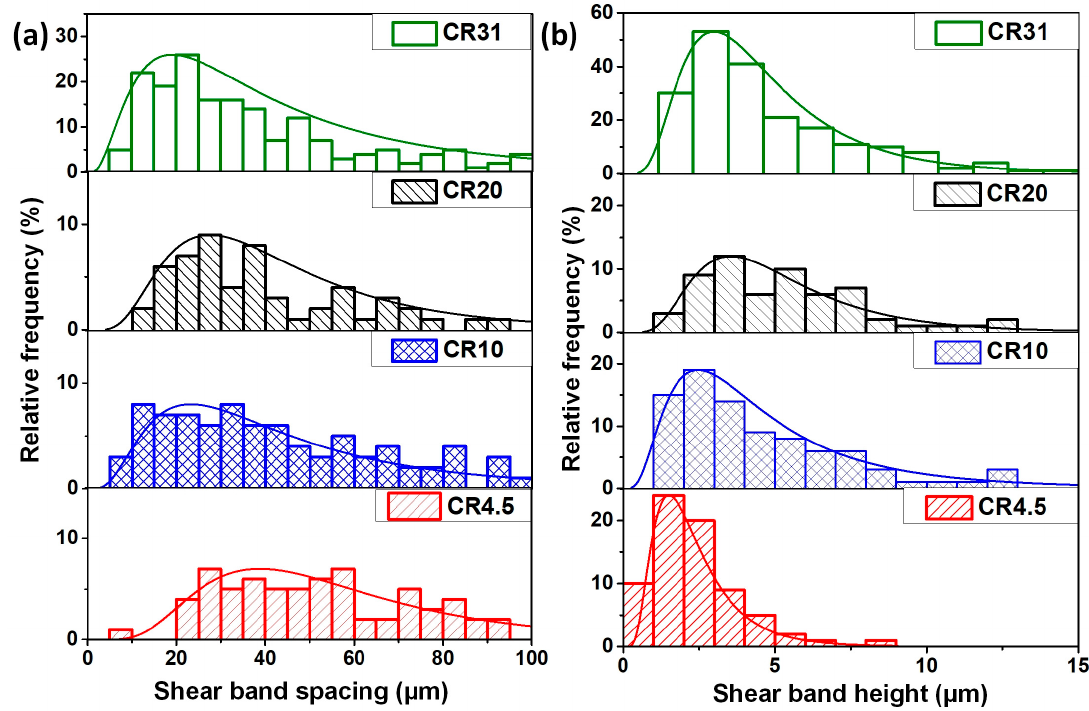
Figure 5. Histogram plot showing the distribution of ( a ) shear band spacing and ( b ) shear band offset height in CR specimens.